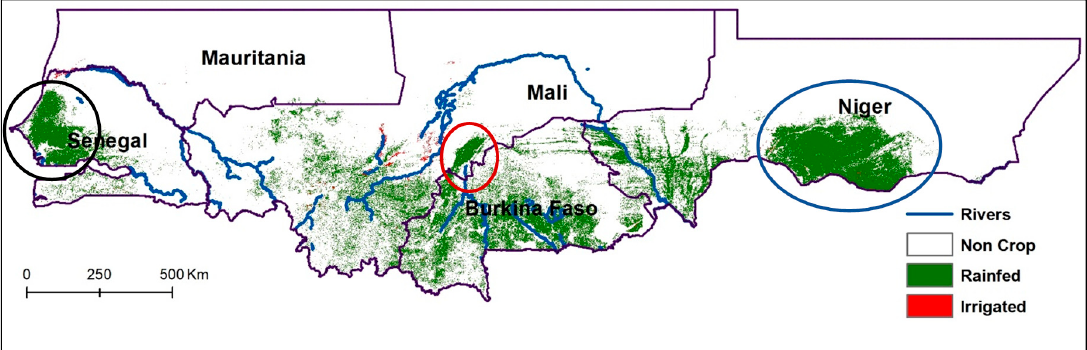
Figure 9. The West African Sahel cropland map (WASC30) with hotspots of intensive rainfed cropland in Senegal, Mali and Niger.